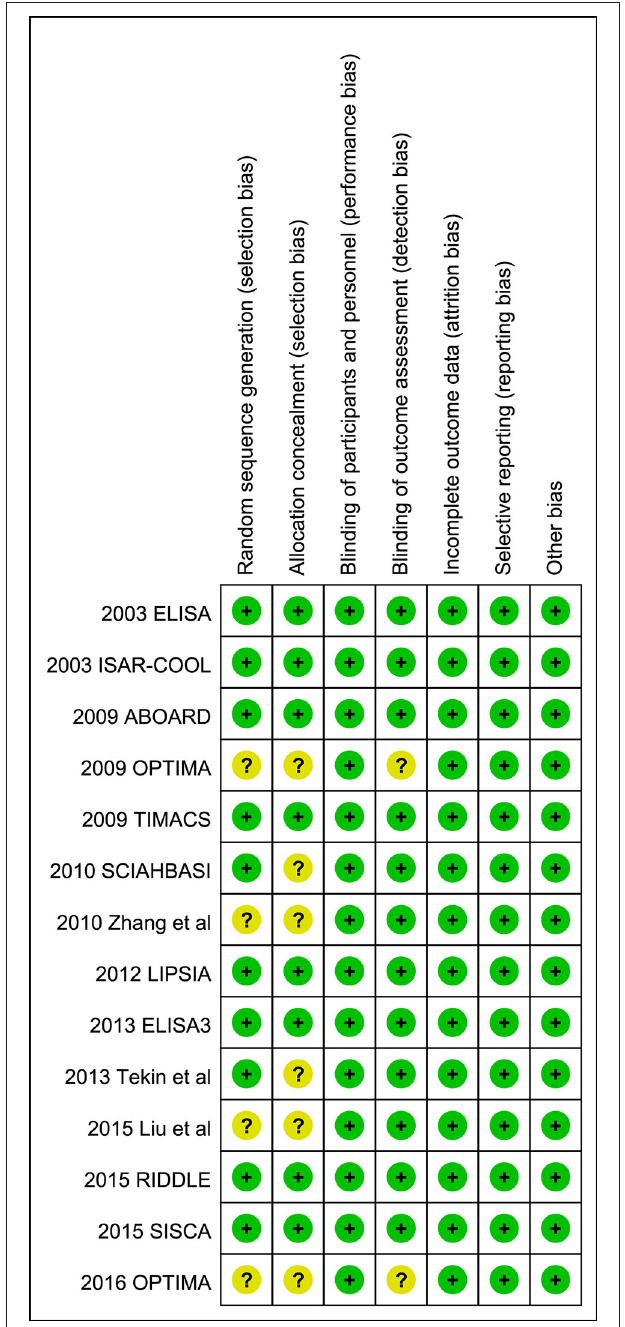
FIGURE 2 | Risk of bias graph: review authors’ judgements about each risk of bias item presented as percentages across all included studies.